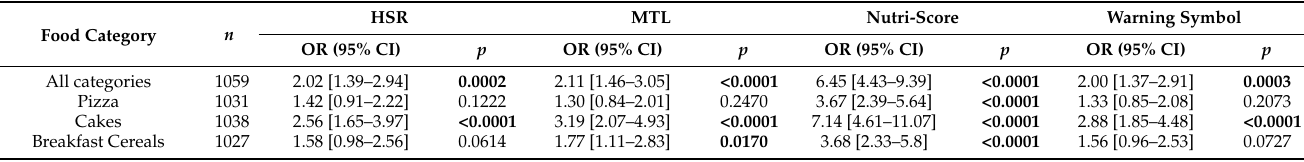
Table 2. Association between FoPLs and the ability to correctly rank products according to nutritional quality. Food